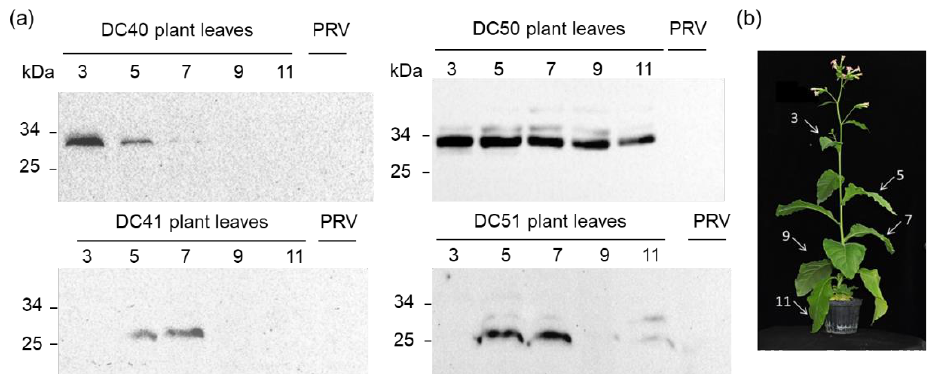
Figure 6. In planta stability of AA9 LPMO recombinant proteins accumulated in DC40/DC41 (TaAA9B) and DC50/DC51 (TrAA9B) transplastomic plants. Protein accumulation level in leaves at different development stages by Western blot analysis ( a ). Arrows indicate leaves sampled for protein analyses, where 3 indicates the youngest leaf, 11 the oldest one ( b ).